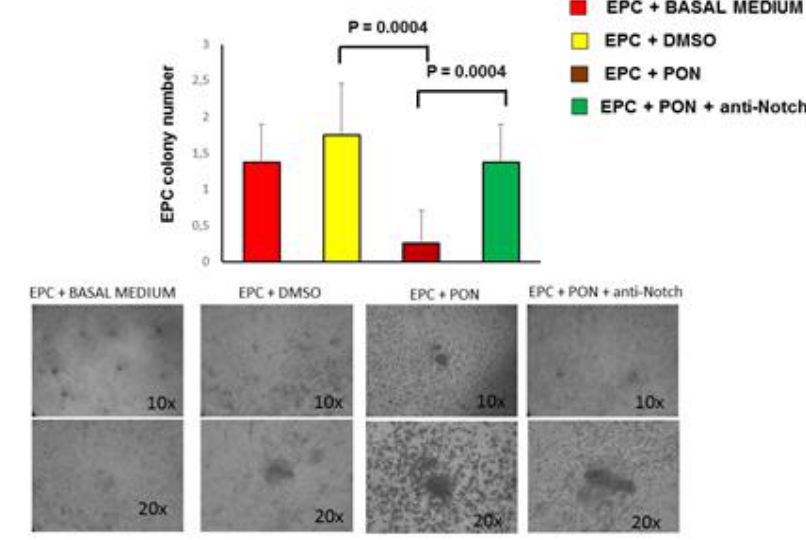
Figure 5. E ff ect of ponatinib and Notch-1 signaling inhibition on EPCs functional properties. Peripheral blood mononuclear cells (PBMCs) were plated on fibronectin-coated 24-well plates and treated, after 4 days, with 1.7 nM of ponatinib or DMSO, in the presence or absence of 1 μg/mL neutralizing factor anti-Notch-1 antibody. After 17 h of treatment, the number of colonies per field in endothelial progenitor cells (EPCs) cultured with or without ponatinib was evaluated by an inverted microscope. Shown are representative fields (10× and 20× magnification) of phase contrast. The pictures are from one representative experiment. The graph, showing number of colonies per field, represents quantification of three experiments ± standard deviation. Abbreviations: Pon, ponatinib; DMSO, dimethyl sulfoxide.